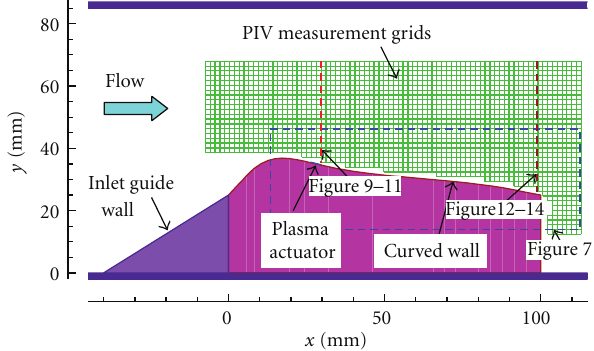
Figure 4: Test section and PIV